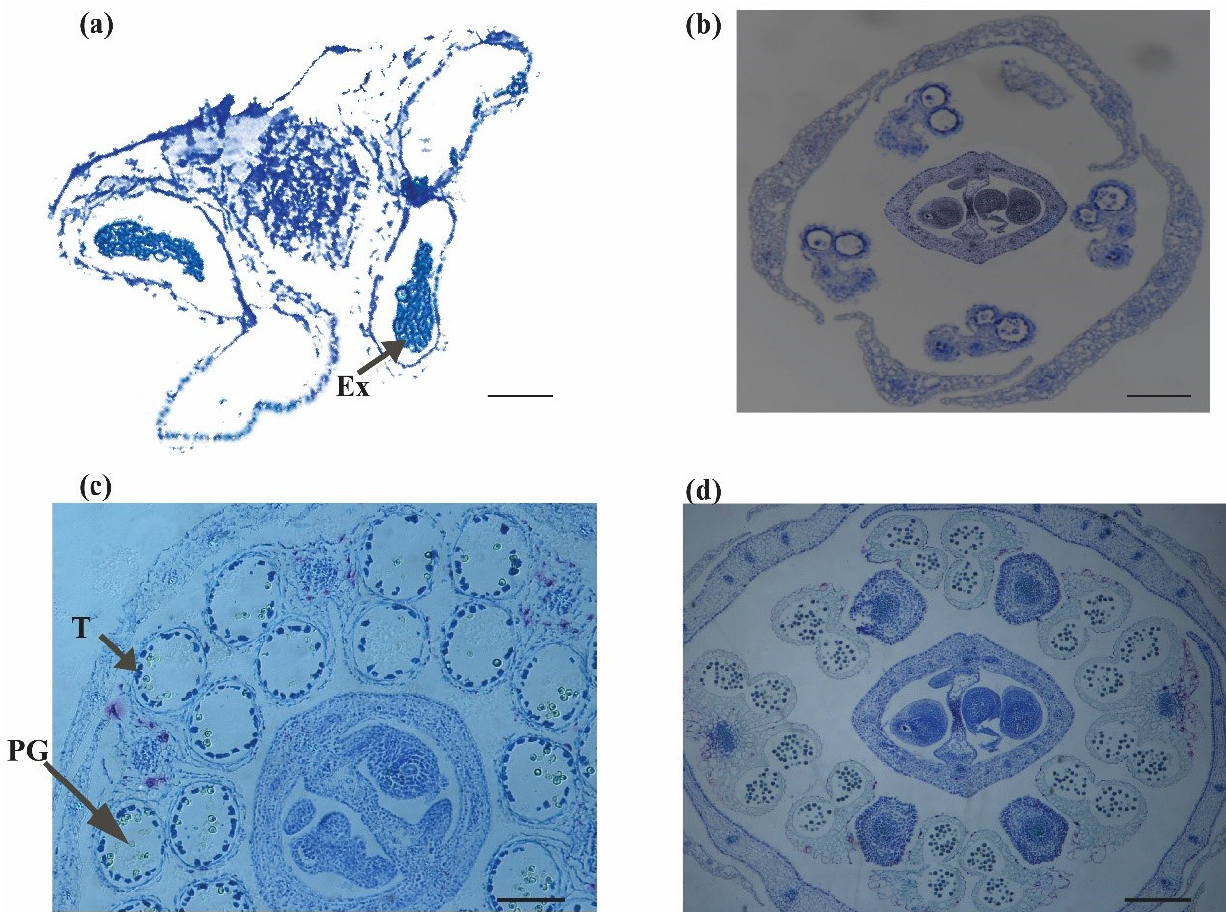
Figure 9. Dehiscence stage of bnarfl11 compared with W.T. ( a , b ) bnarfl11 dehiscence stage. ( a ) Heap of scarring in exine (Ex) if four locks succeed in development. ( b ) The loss of adaxial or abaxial locules is evident in the bnarfl11 . ( c , d ) Wild-type flowers at dehiscence, with four locules and normal mature pollen grains. Bar = 10 μm.